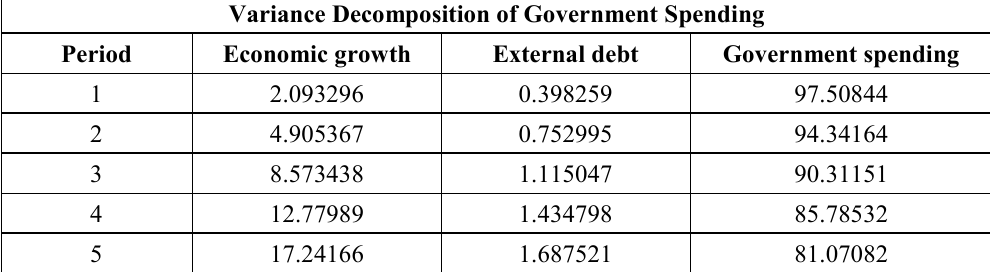
Table 13 . Variance Decomposition of Lgexp